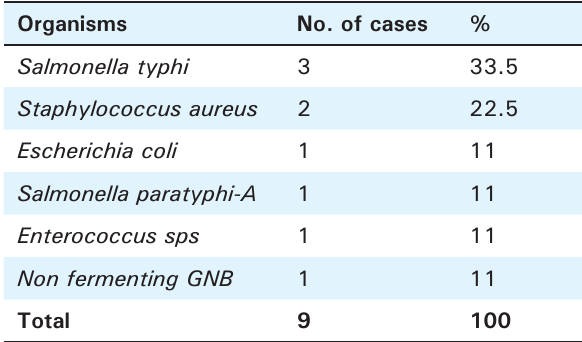
Table 5. Comparison of 5 studies evaluating detection of organism by bone marrow culture in patients